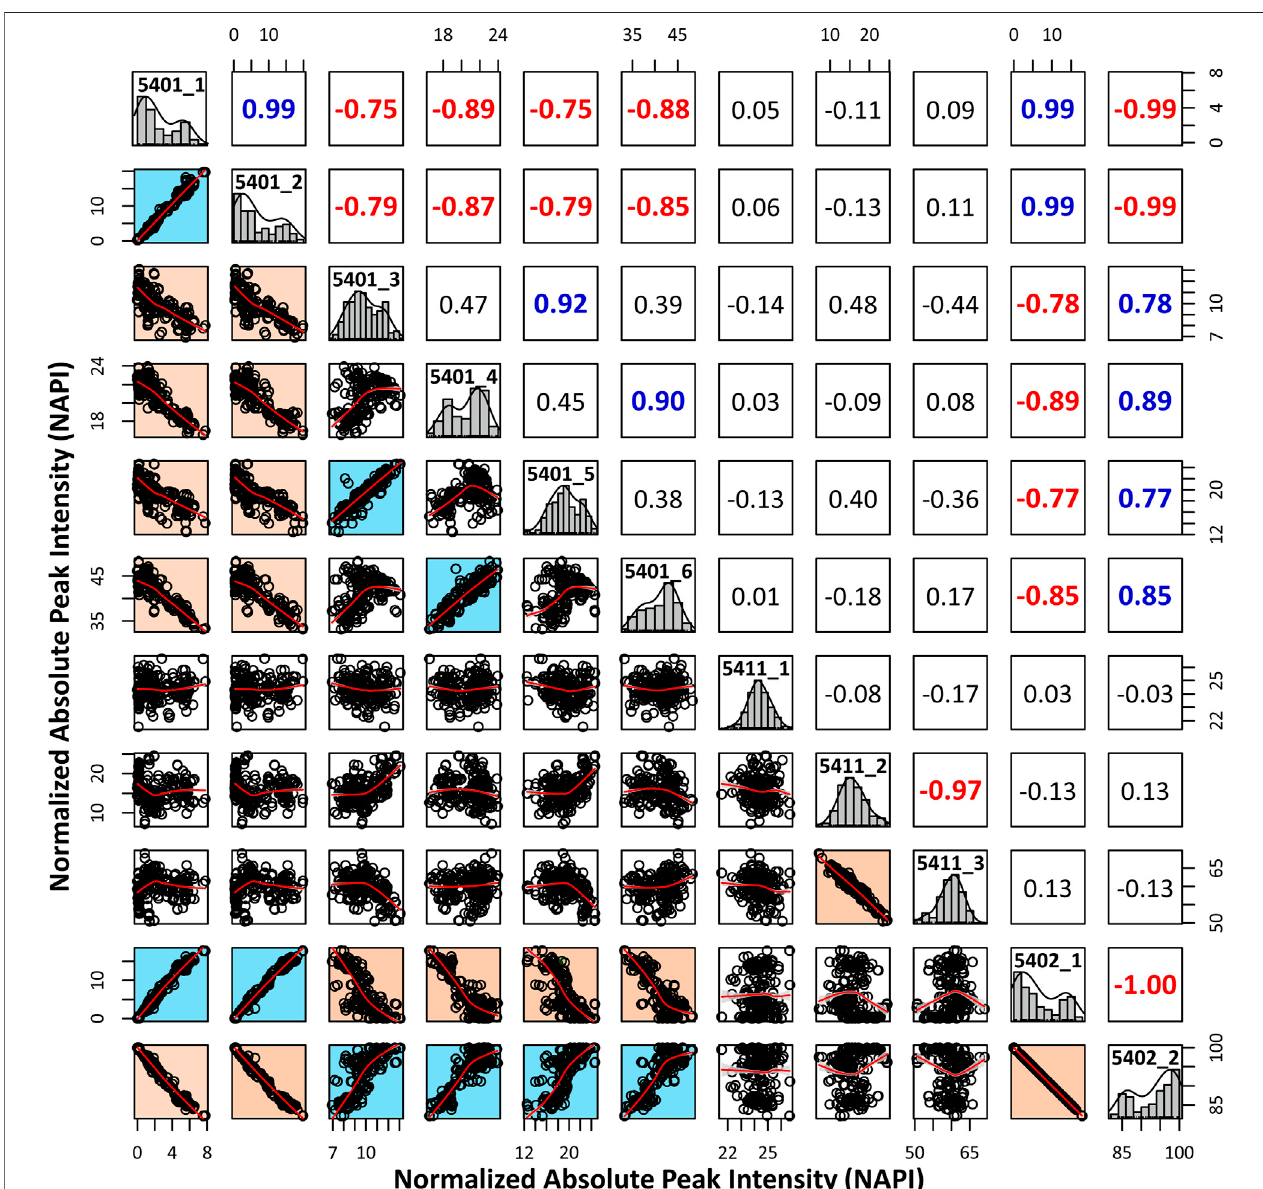
FIGURE 5 | Pearson correlation analysis to investigate associations between isomers with different sialic acid epitopes. The normalized absolute peak intensities (NAPIs)of11isomersinallserumsampleswereusedforcalculations.Thescatterplotmatrixindicatestheassociationbetweeneachisomer,andthePearsoncorrelation coef fi cient ( r ) is above the diagonal. Information for each isomer is displayed in a diagonal histogram box (isomer code: glycan composition-elution order).